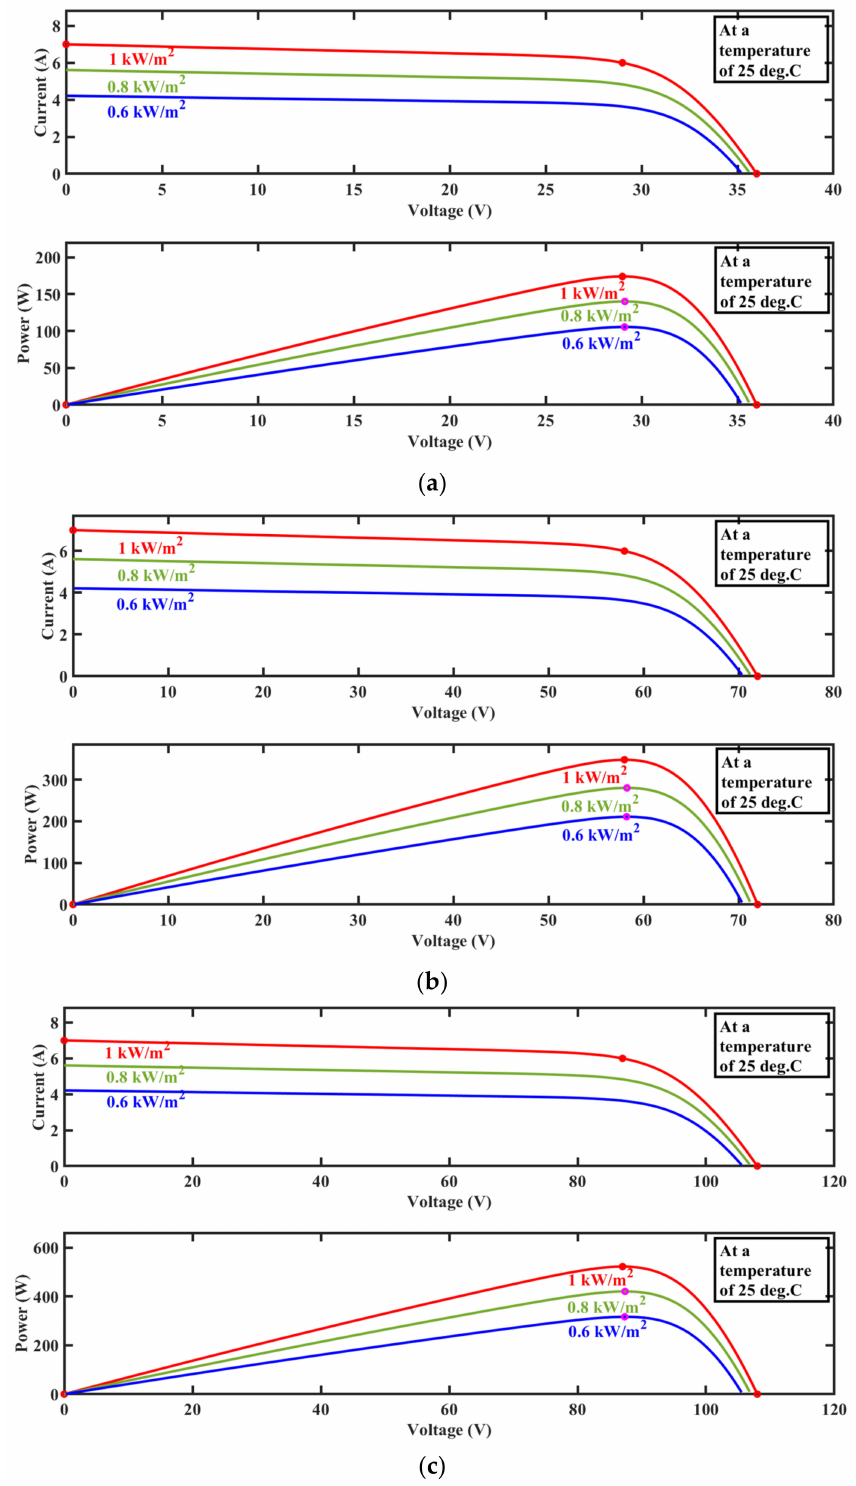
Figure 5. I-V & P-V curves at a constant temperature of 25 ◦ C with variable irradiances of 1000 W/m 2 , 800 W/m 2 and 600 W/m 2 ( a ) PV 1 , ( b ) PV 2 and ( c ) PV 3